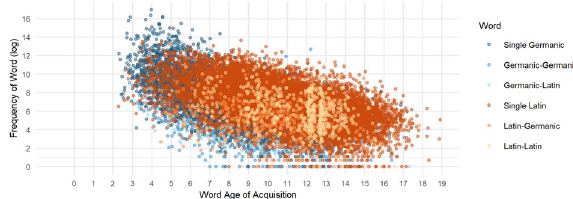
Fig. 2 Items that begin with a Germanic item or are single Germanic words are represented in blue. Items that begin with a Latin item or single Latin items are represented in orange. Germanic words indicated in blue are learned earlier in life and have higher word frequency in adult language than Latin-based items in